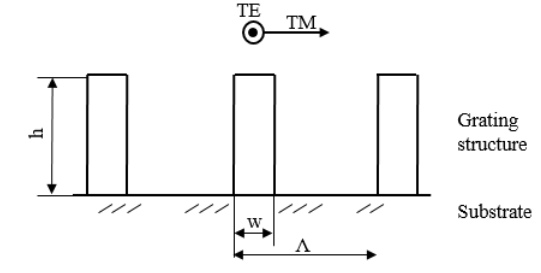
Fig. 1. Schematic grating structure for polarisation control. Direction for TE and TM polarized light is marked.